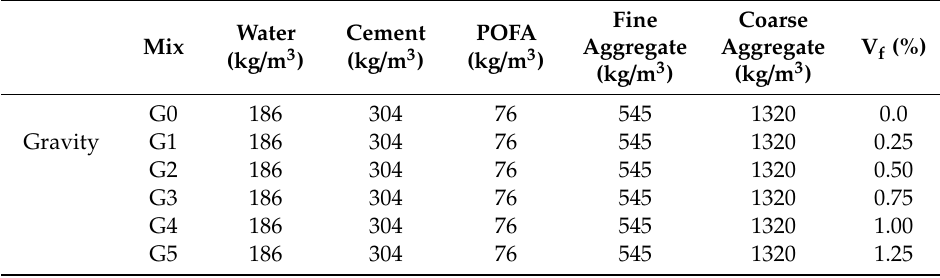
Table 3. Proportions of various components used in the pre-packed aggregate fibre-reinforced concrete (PAFRC) mixes.